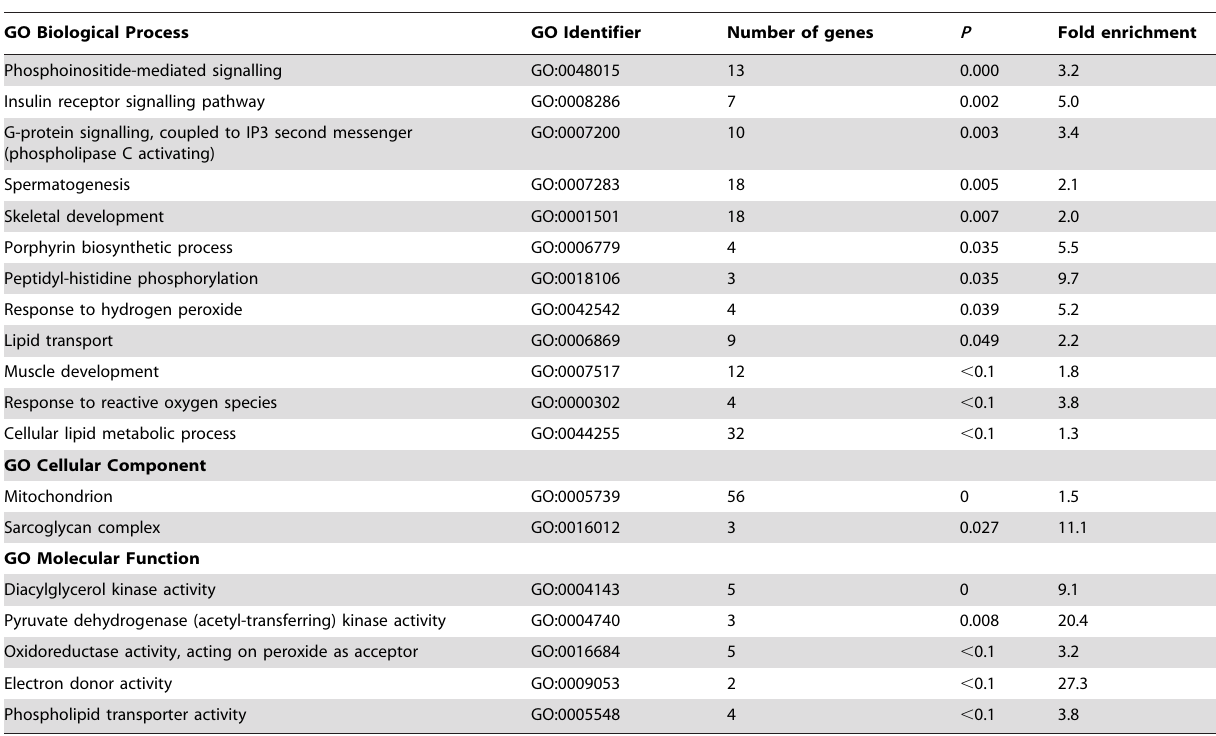
Table 2. Overrepresented gene ontologies